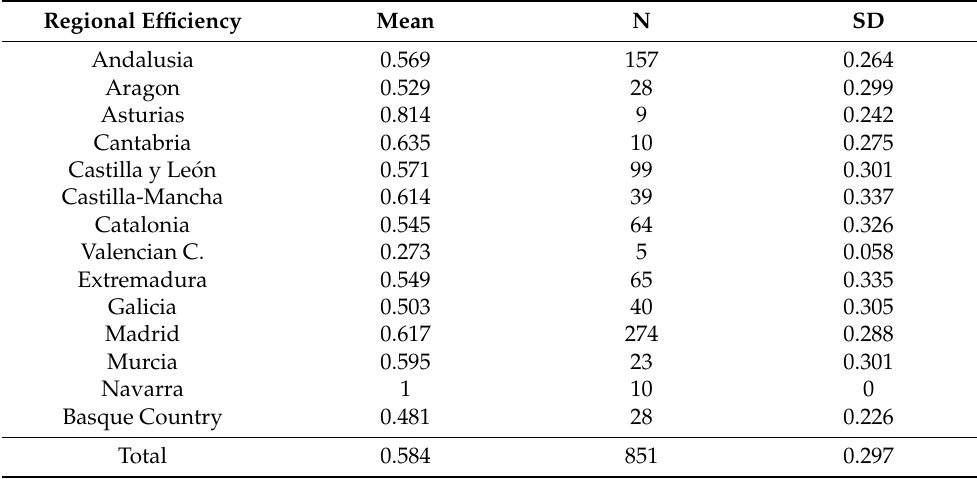
Table 6. Regional efficiency results in cultural tourism